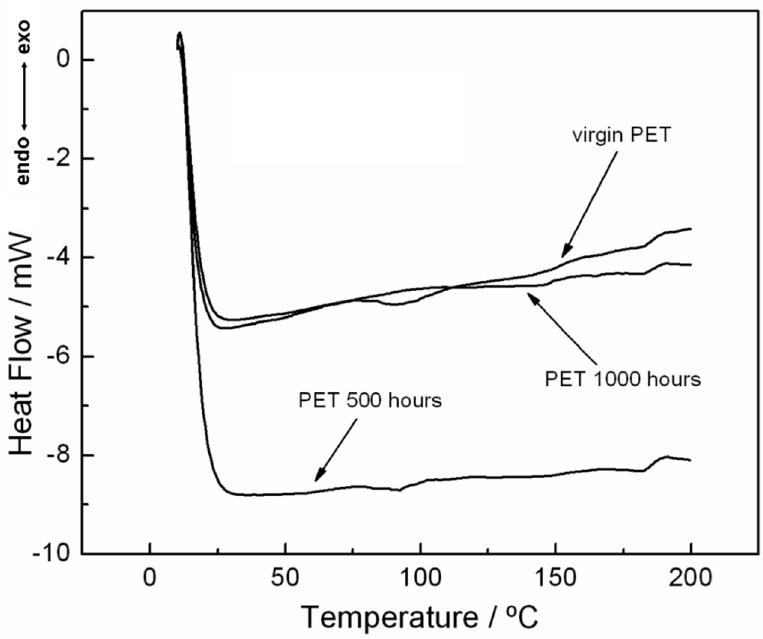
Figure 12. Analysis of glass transition from DSC curves with a heating rate of 30 °C·min − 1 under nitrogen gas purge with flow of 50 mL min − 1 in an aluminum crucible.